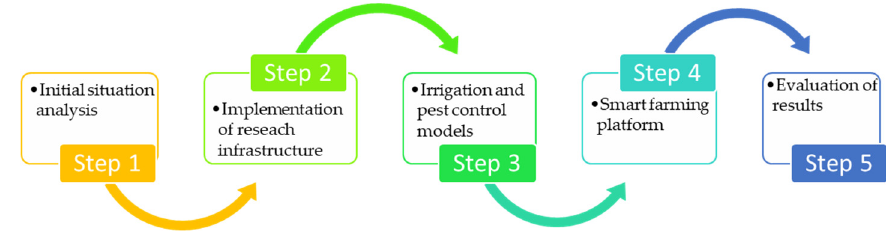
Figure 4. Flow chart.